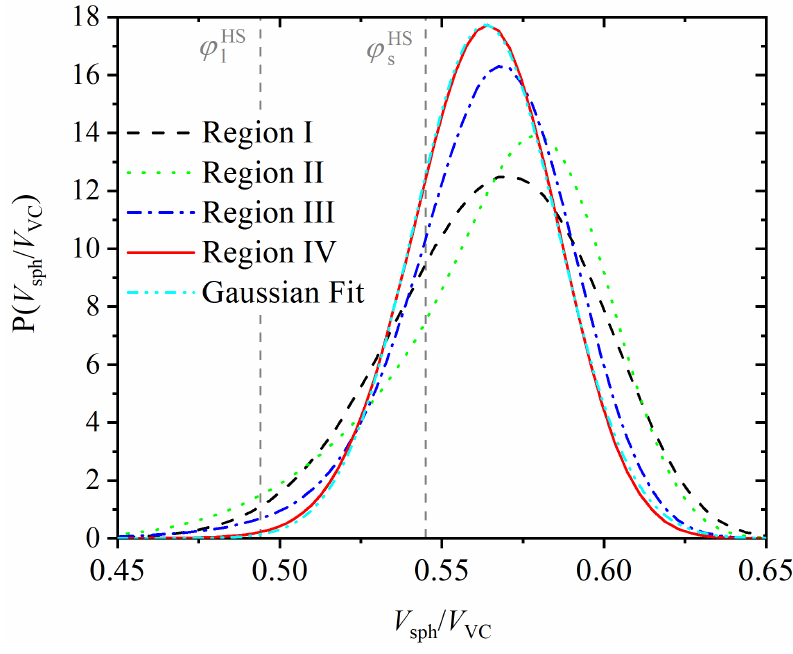
Figure 10. Local volume fraction distribution for the four different regions. The local volume fraction for a given monomer is defined as the ratio of the volume of a monomer ( V sph = π of its Voronoi cell V VC . The average of all distributions is identical and coincides with the overall volume fraction ϕ = 0.56. The equilibrium distribution (Region IV) follows the Gaussian behavior to excellent accuracy, as can be seen by the corresponding fit, with 0.563 and 0.0227 being the mean and standard deviation, respectively. Vertical dashed lines mark the volume fractions of the liquid and solid phases of the monomeric HS fluid at equilibrium, ϕ HS